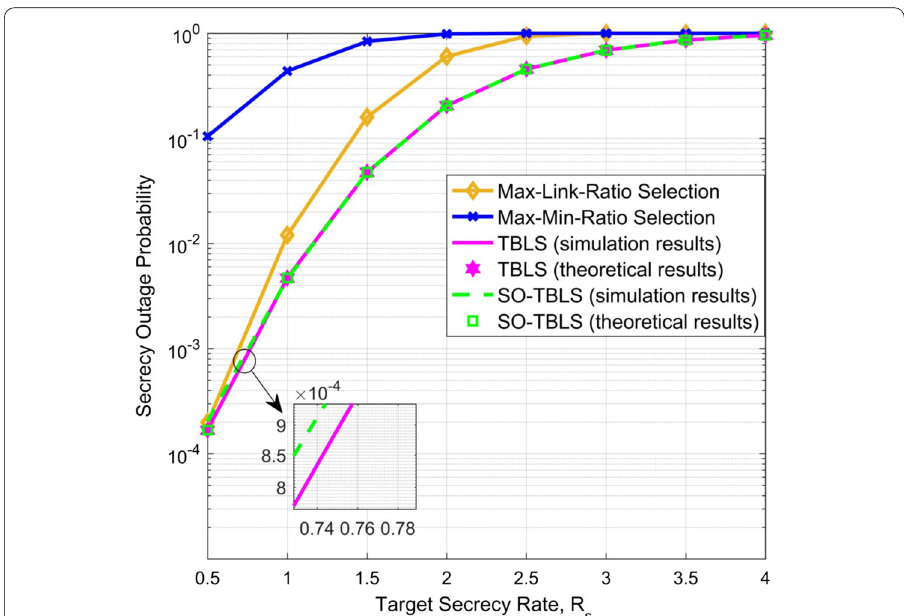
Fig. 7 The secrecy outage probability versus the target secrecy rate for different relaying